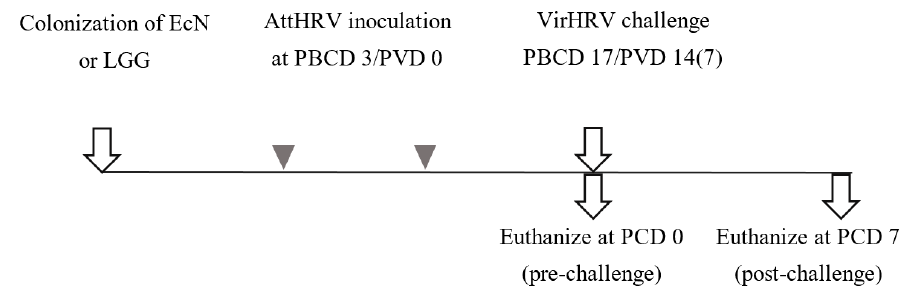
Figure 1. Experimental design showing timepoints for colonization of Escherichia coli Nissle (EcN) 1917, Lacticaseibacillus rhamnosus GG (LGG) probiotics, live oral attenuated human rotavirus (AttHRV) day, PBCD; post vaccination day, PVD; post challenge,